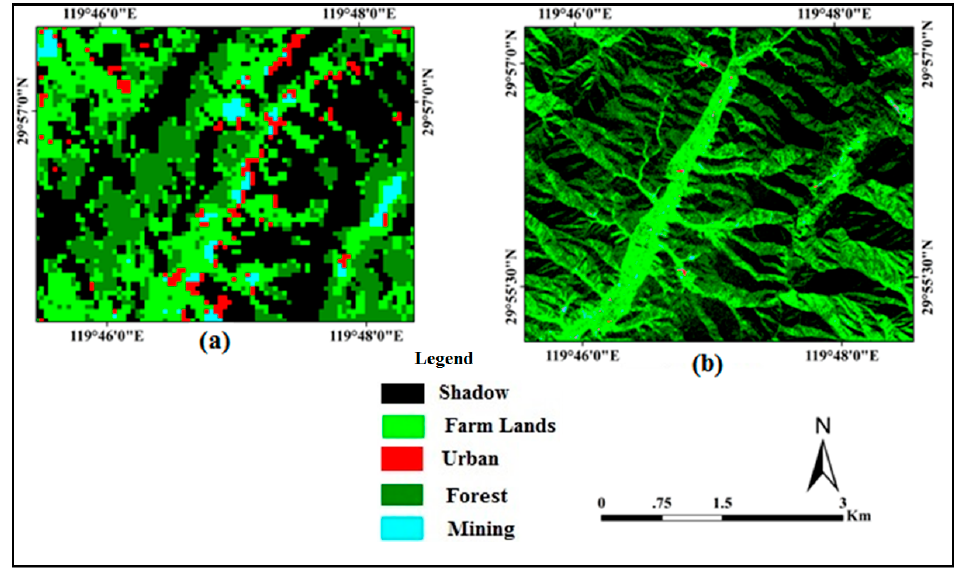
Figure 7. Maps of land cover in a forested region produced by: ( a ) Landsat MSS using SVM hard classifier; and ( b ) CORONA using density slicing.